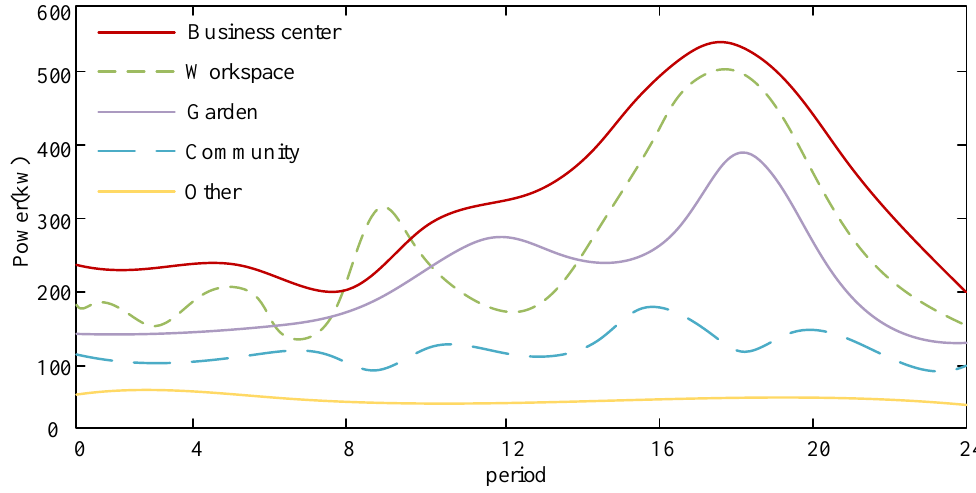
Figure 8. Forecast of charging demand for electric vehicles in different regions.